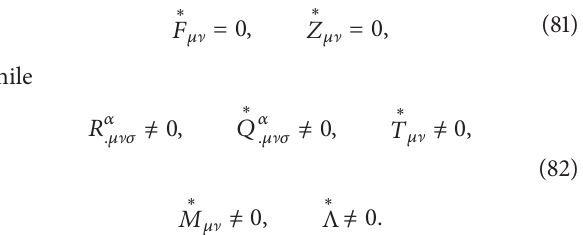
∗ 𝑍 (since 𝜇 ] has no linear terms in